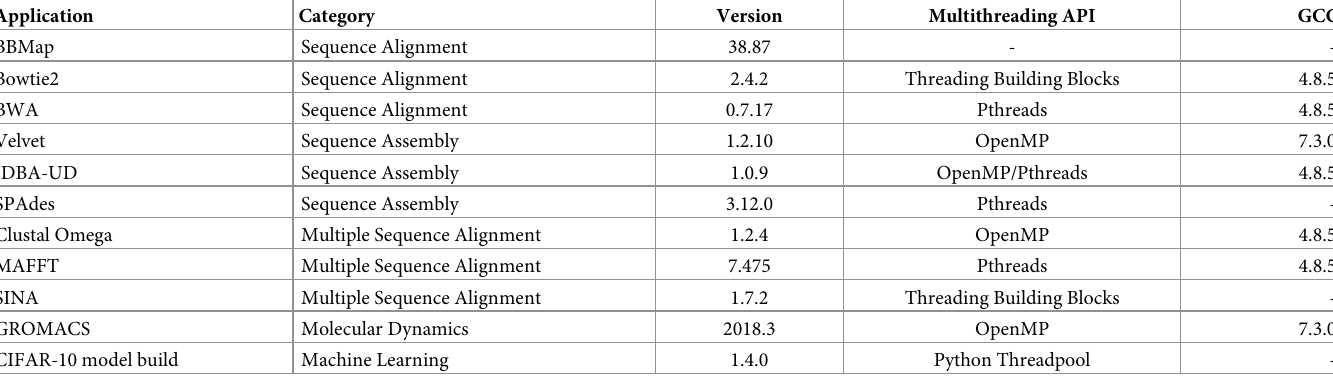
Table 1. BOOTABLE benchmark applications, including their general category, version, used multithreading API and the GCC compiler version, whereas an already compiled binary is used for SPAdes BBMap and SINA. TensorFlow is installed via Python pip. For BBMap, implemented in the programming language Java, no note about the used multithreading API could be found.